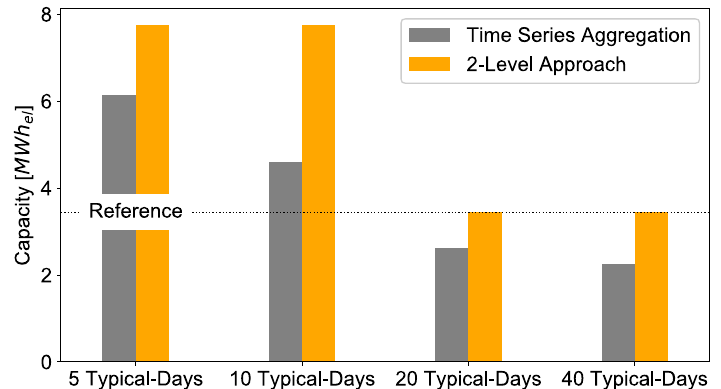
Figure 20. Deviation of installed battery capacities with the 2-Level Approach and time series aggregation compared to full time series.